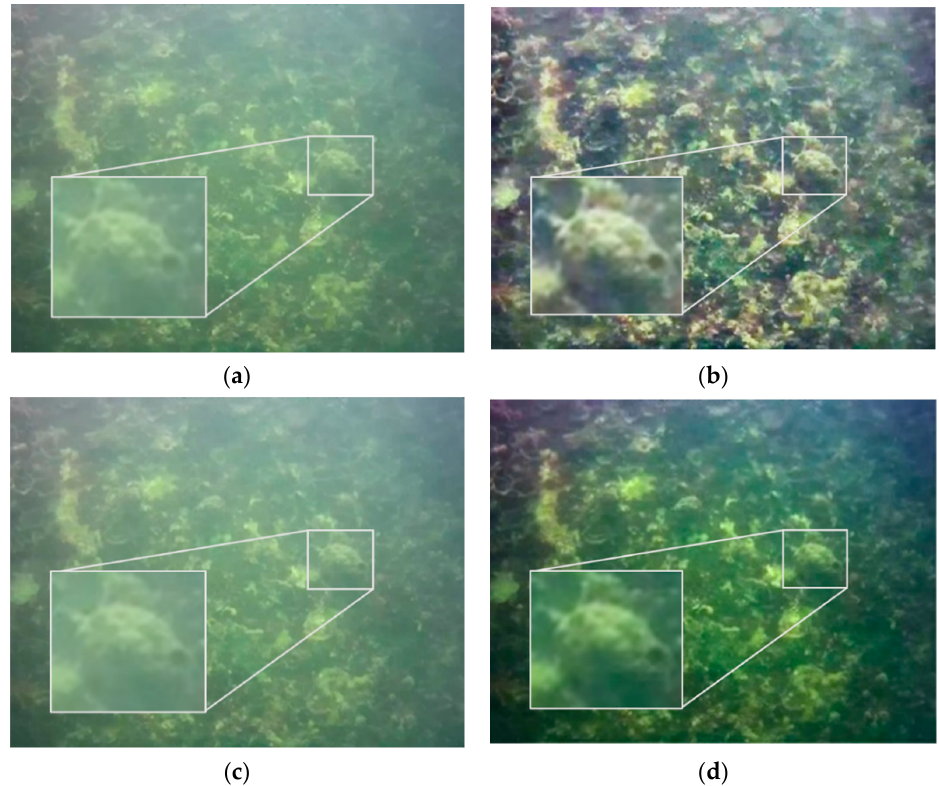
Figure 6. Test 2 image enhancement results. ( a ) Original image; ( b ) CLAHE; ( c ) MF; ( d ) DCP.